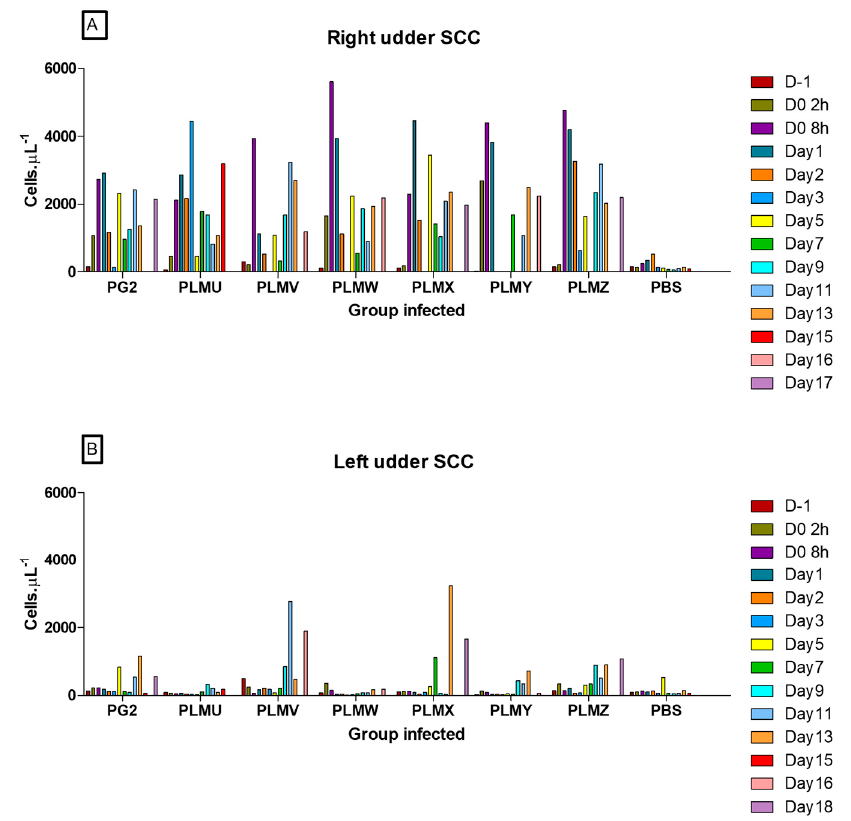
Figure 5. Single Cell Counts in milk from right ( A ) and left ( B ) udder halves of sheep infected with different PLMs and the positive (PG2) and negative (PBS) controls.